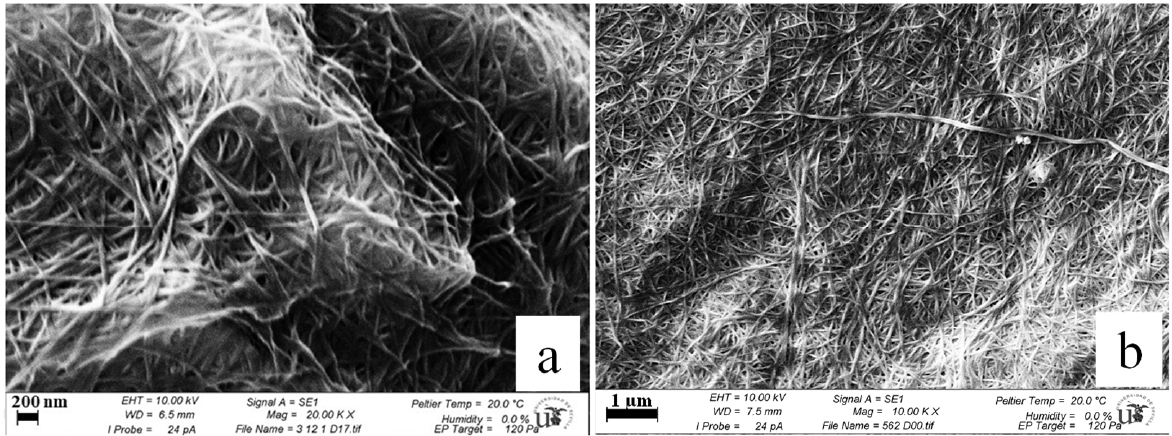
Figure 5. SEM images of surface morphology of purified BC. ( a ) aspect of BC fibrillar network structure; ( b ) aspect of BC surface morphology.